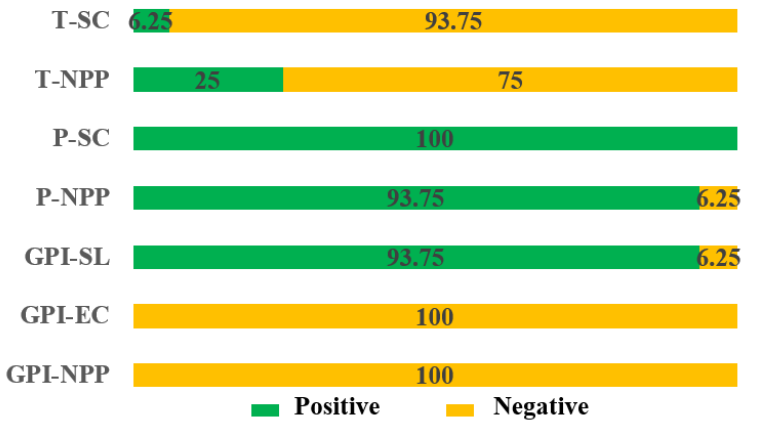
Figure 11. Quantitative effects of climate change and grazing pressure on the relationship between grassland degradation and ecosystem services. T, temperature (°C); P, precipitation (mm); GPI, grazing pressure index; NPP, net primary production (kg C/m 2 ); EC, ecosystem carbon (kg C/m 2 ); SC, soil conservation (t/ha); SL, soil loss by wind (kg/m 2 ). Table 3. Effects of climate change and grazing pressure on the relationship between grassland deg- radation and ecosystem services under different degradation gradients.